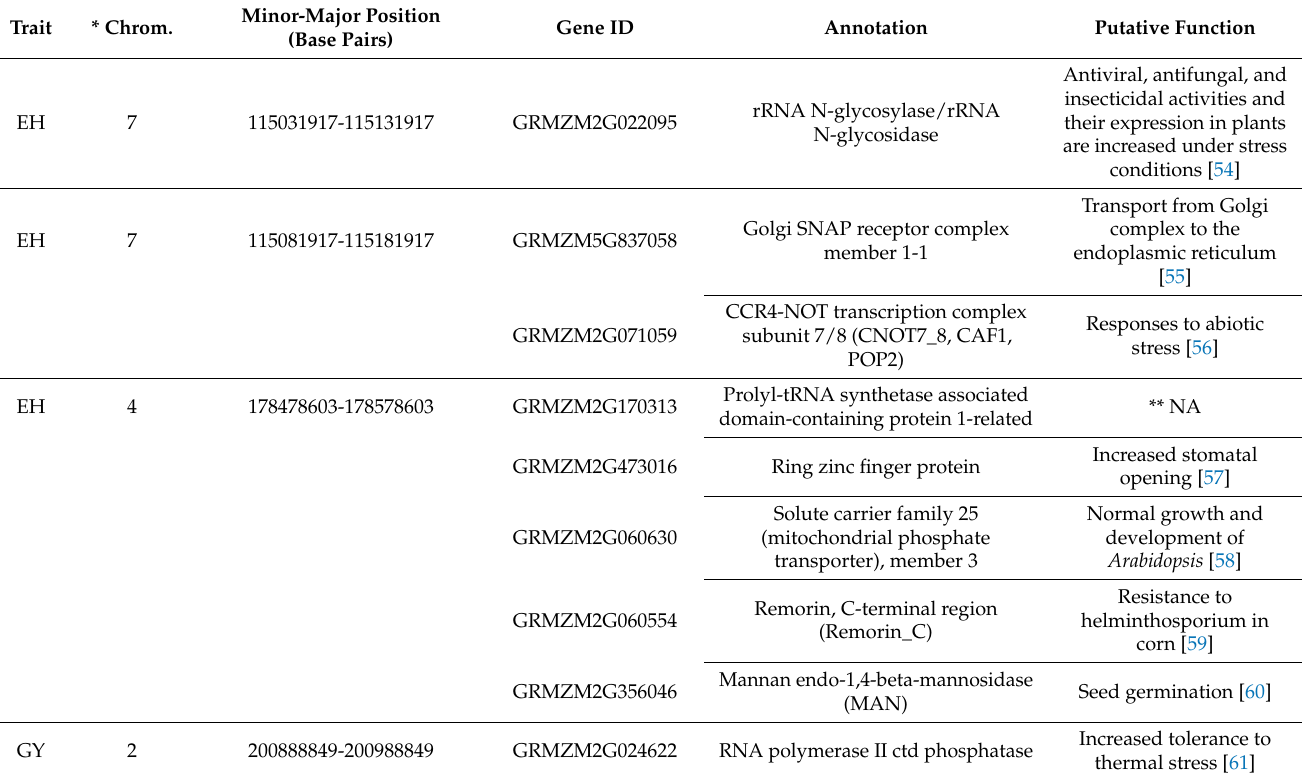
Table 2. Candidate genes detected by regional heritability analysis for four traits of interest for popcorn in environment ENV2. Trait *